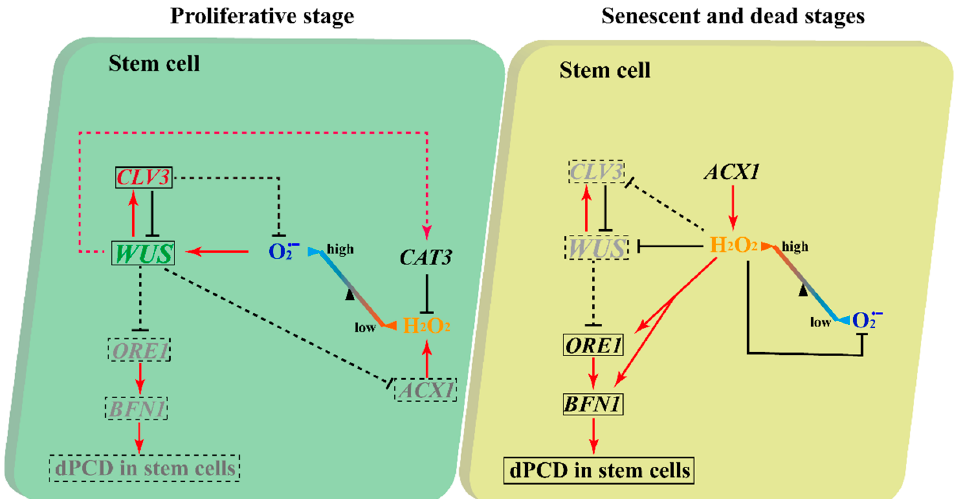
Figure 11. The putative model of ROS-mediated dPCD in stem cells. During the proliferative stage, WUS is promoted by O 2 ·- and inhibited by CLV3 at the same time. WUS may promote CAT3 expression and repress ACX1 expression to keep O 2 ·- at high levels and H 2 O 2 at low levels in stem cells. Meanwhile, WUS may repress the ORE1 - BFN1 cascade to prevent dPCD from occurring at the wrong time point. CLV3 may also inhibit O 2·- production via unknown pathways to repress WUS indirectly. During senescence and death stages, ACX1 may induce age-dependent H 2 O 2 accumulation and bursts in stem cell populations. A high level of H 2 O 2 can decrease O 2·- production and terminate WUS directly. Furthermore, the H 2 O 2 burst may repress CLV3 , leading to the full termination of the WUS-CLV3 feedback loop. Moreover, H 2 O 2 directly triggers the dPCD process by activating the ORE1-BFN1 cascade in stem cells. Lines and arrows indicate the known processes. Dotted lines and arrow lines denote the putative processes.